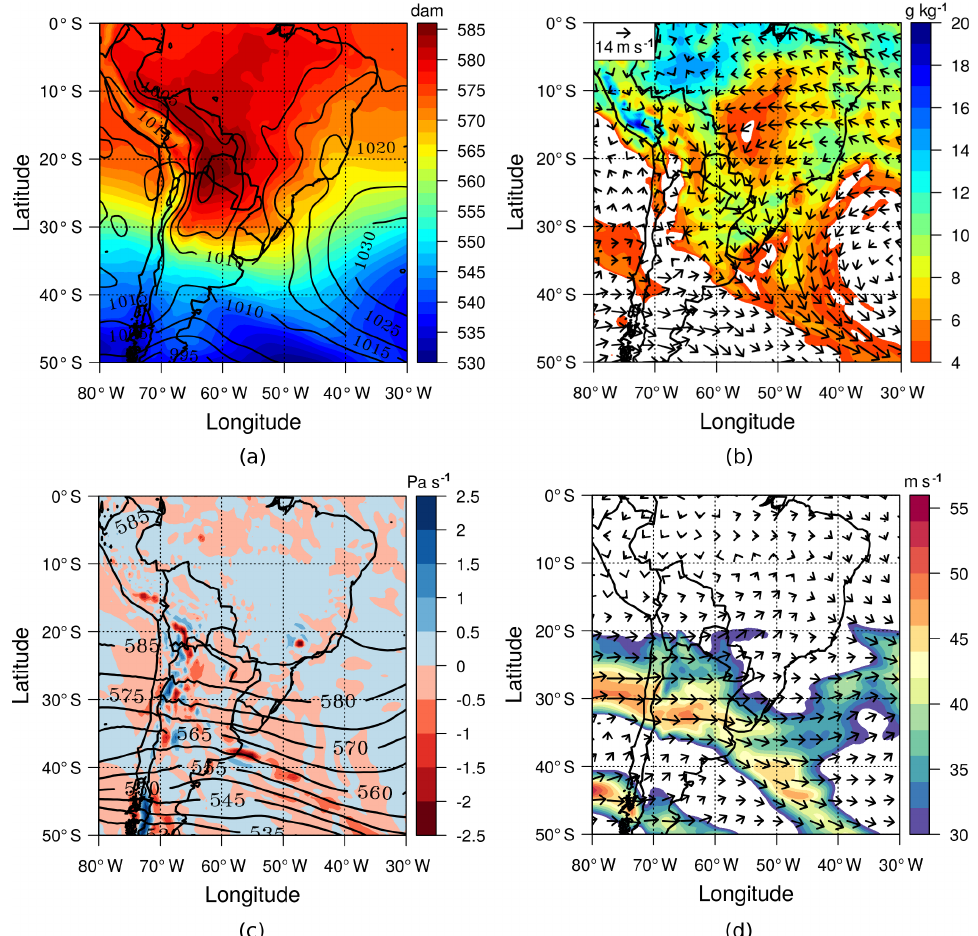
Figure 4. Synoptic fields on 21 September 2010 at 00:00UTC: (a) sea-level pressure (contour lines) and thickness (shaded); (b) wind (vectors) and specific humidity (shaded) at 850hPa; (c) geopotential height (contour) and vertical p velocity (shaded) at 500hPa and (d) wind direction (vector) and magnitude (shaded) at